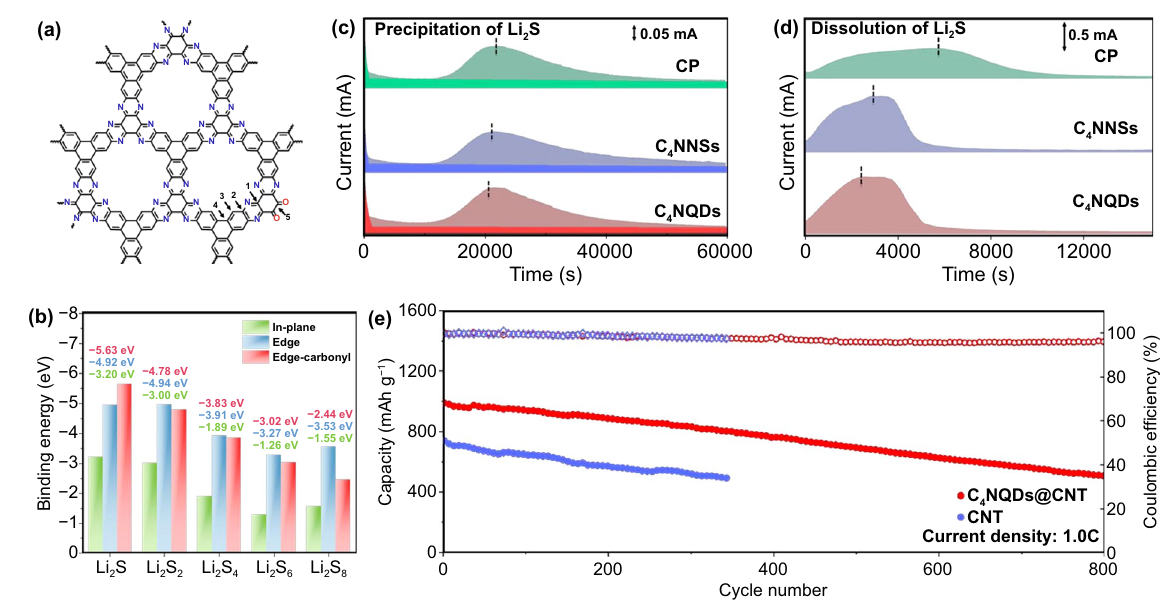
Fig. 10 a Schematic illustration of the structure of C 4 N. b Adsorption energies for Li 2 S, Li 2 S 2 , Li 2 S 4 , Li 2 S 6 , and Li 2 S 8 on various sites of C 4 N. c Potentiostatic discharge curves and d potentiostatic charge curves of Li 2 S precipitation on the CP, C 4 NNSs/CP and C 4 NQDs/CP. e Cycling per‑ formance of cells with CNT modified separator and C 4 NQDs@CNT modified separator at 1.0C [112]. Copyright 2021,